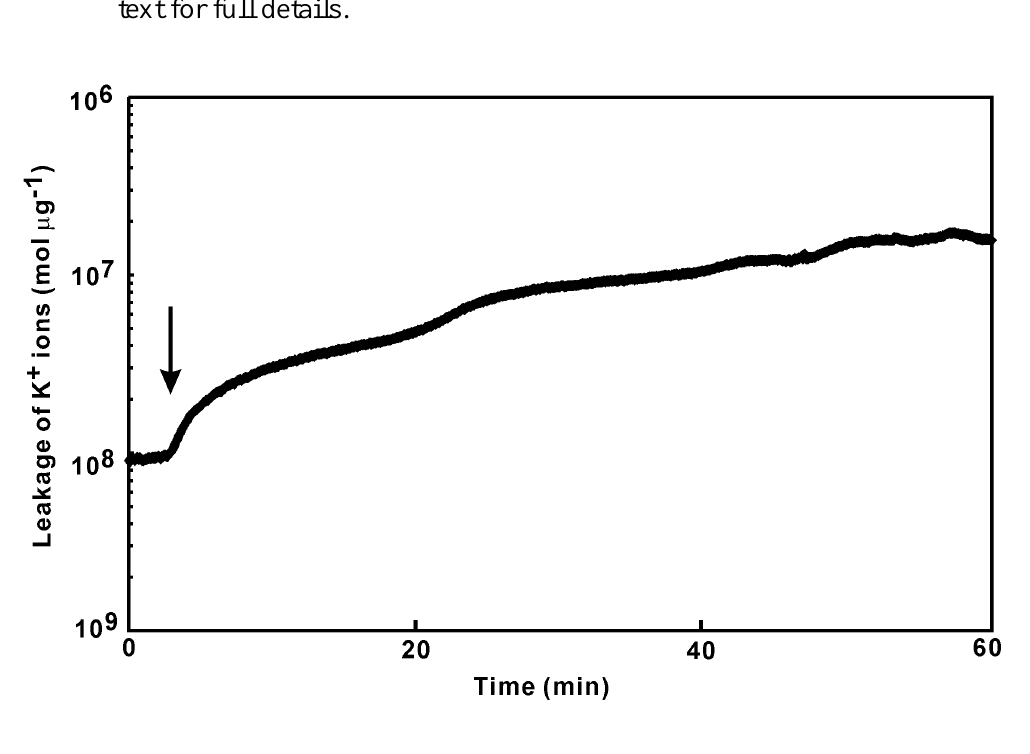
Figure 4. Changes in the concentration of K + ions in a suspension of S. aureus FDA209P in response to 1-decanol. The arrow indicates the addition of 1-decanol. The results are typical of three assays that gave similar results. See text for full